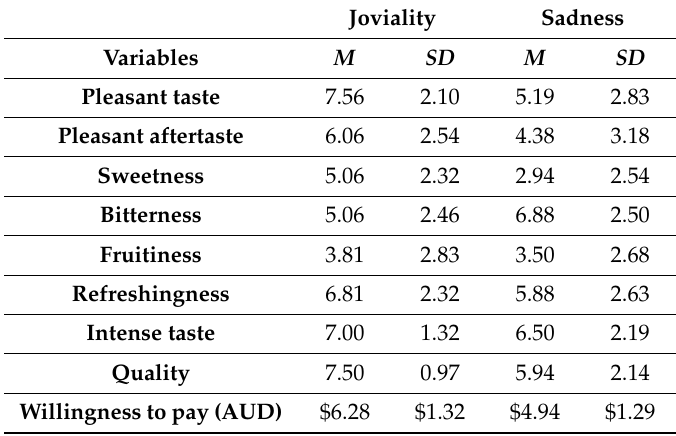
Table 1. Descriptive statistics for beer flavor characteristics for joviality and sadness